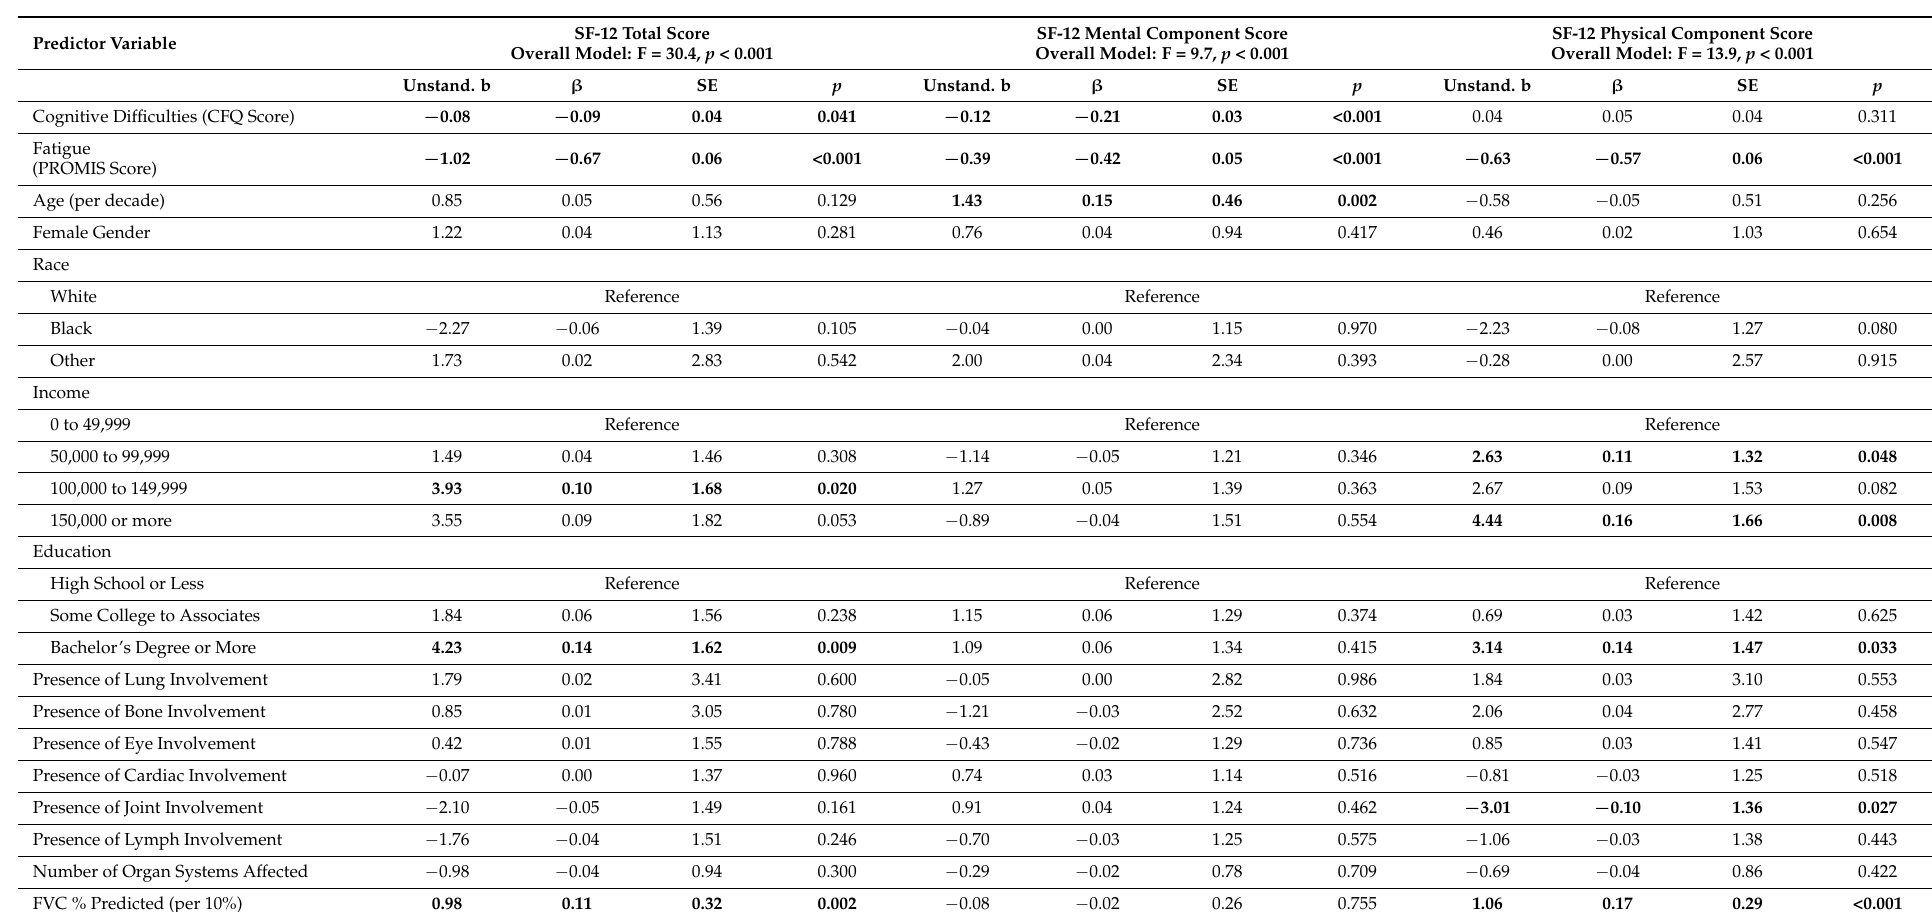
Table 2. Associations between demographic and clincial variables and health-related quality of life subscales (SF-12 MCS and PCS): results of linear regression analyses (N =